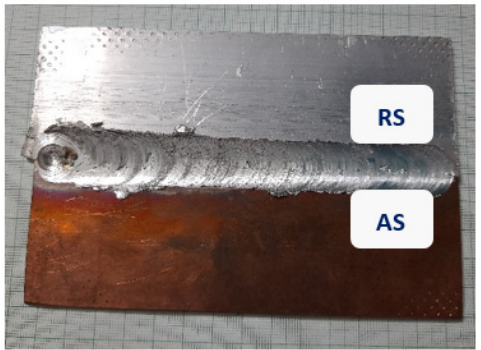
Figure 8. FSW weld joint with Cu (AS) and Al (RS).